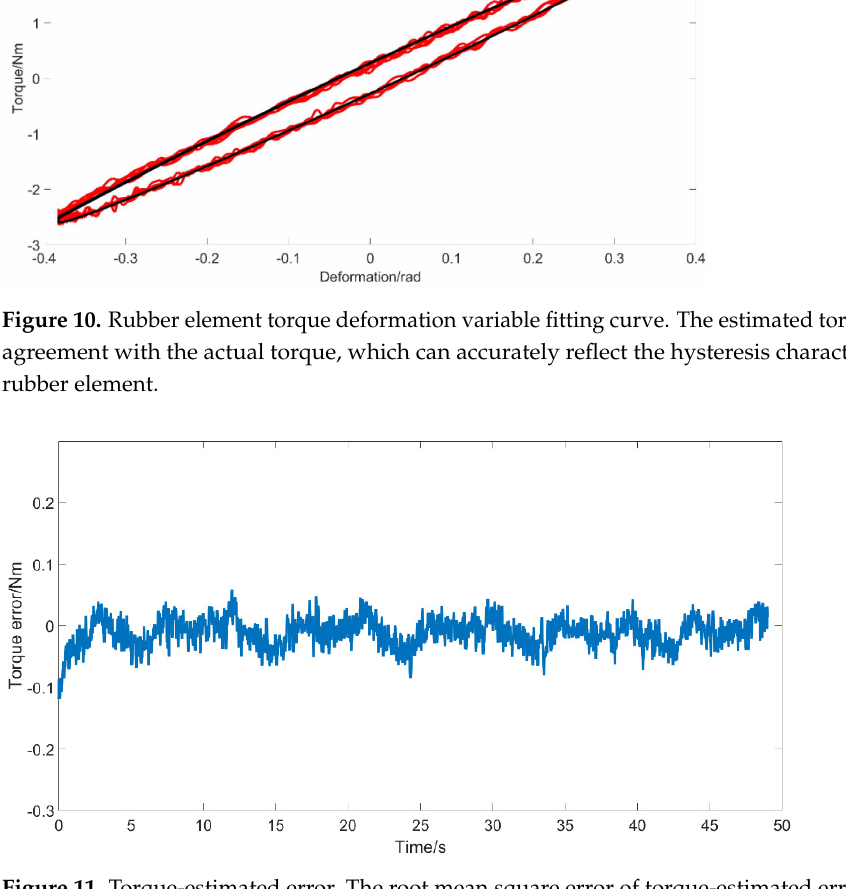
Figure 11. Torque-estimated error. The root mean square error of torque-estimated error is 0.03 Nm.